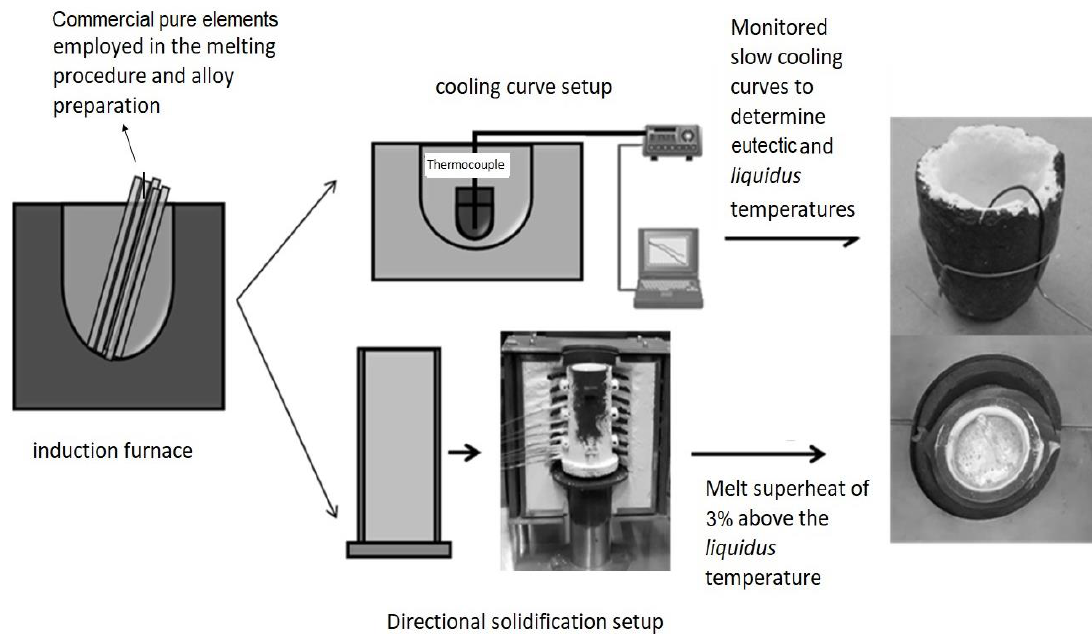
Figure 1. Overall sketches showing two adopted techniques dealing with the molten Al-11Si(- x Cu) alloys in the present research, which are: the determination of cooling curves and consequently liquidus/eutectic temperatures, and an assembly of the directional solidification system with insertion of thermocouples within a split stainless steel